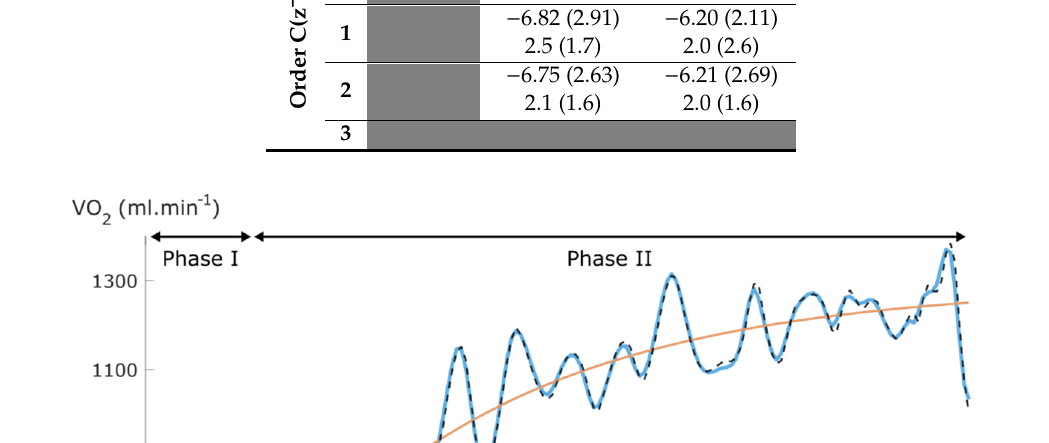
Table 2. Model performance characteristics for identification of the noise model order. Dark squares show noise model orders that resulted in visually inappropriate full model fits. Upper values for every noise model structure are Young Identification Criterion (YIC) values, and lower values are normalised root-mean-squared error values (NRMSE) (%).